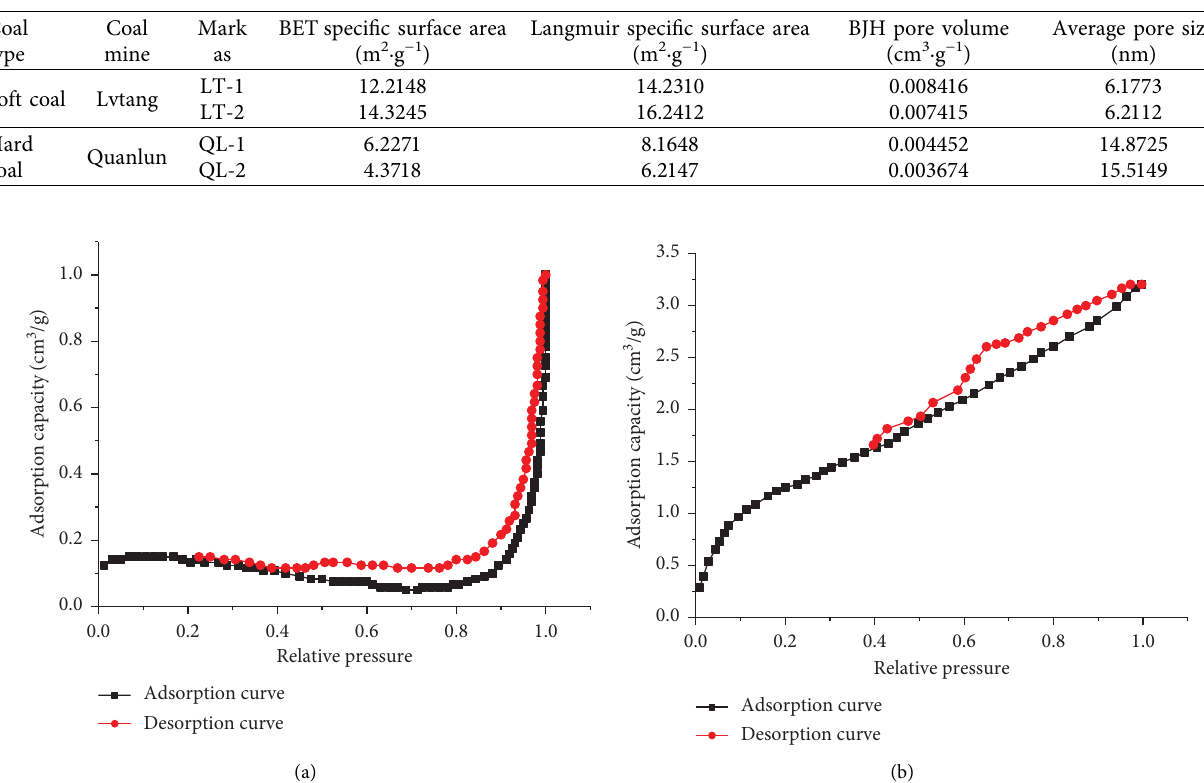
Table 2: Coal sample nitrogen adsorption test